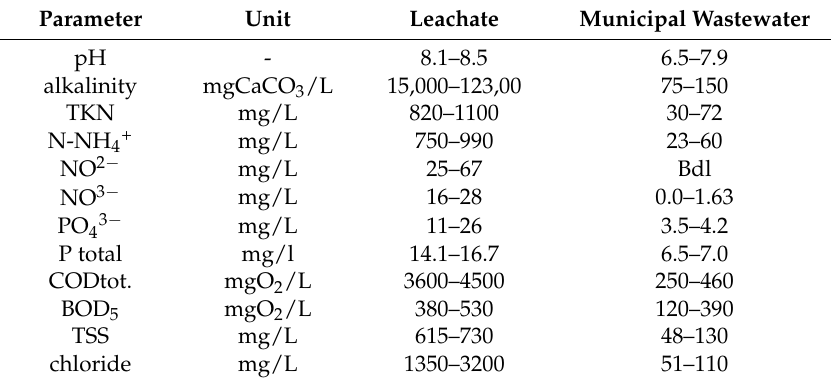
Table 2. Characteristic of wastewater used in this